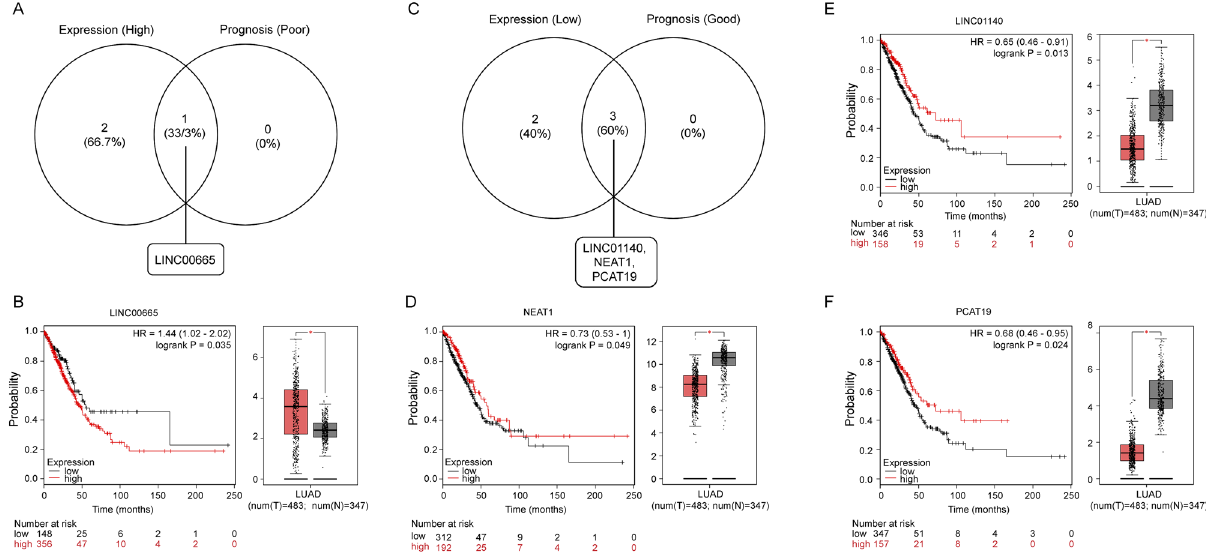
Figure 6. Screening the key lncRNAs in LUAD. ( A , B ) Identification of the key long noncoding RNAs (lncRNAs) with high expression and poor prognosis values among the predicted candidate lncRNAs by combining expression and prognosis analyses using GEPIA and Kaplan–Meier-plotter databases, respectively. ( C – F ) Identification of key lncRNAs with low expression and better prognosis values among predicted candidate lncRNAs by combining expression and prognosis analyses using GEPIA and Kaplan–Meier-plotter databases,